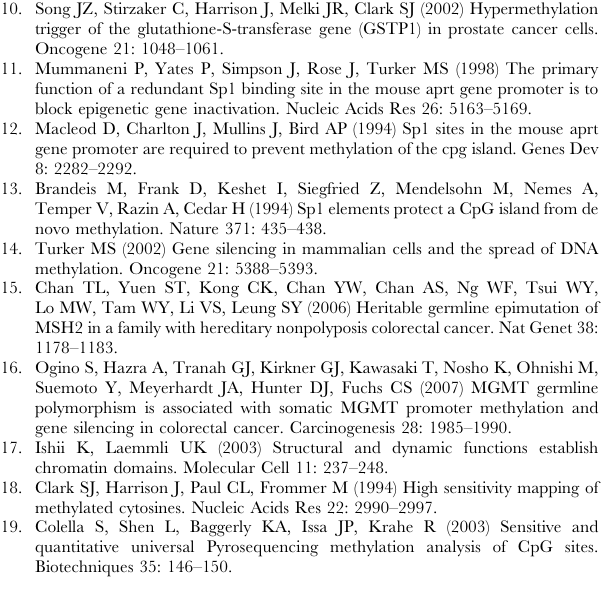
Figure S4 Expression of stably transfected HpaII-seeded constructs in an independent second experiment. Long and short RIL allele-specific constructs (construct B, , 0.6 KB) were seeded with HpaII methylase, stably cotransfected with pcDNA3.1 into NIH3T3 cells, selected in neomycin and pooled clones monitored for the indicated time period. Notice initial equal levels of expression (Day 18), followed by increase or maintenance of the long allele construct expression and in contrast, declining expression of the short allele construct. Table S1 Primer Sequences for the Genes Studied, PCR Conditions, and Assay